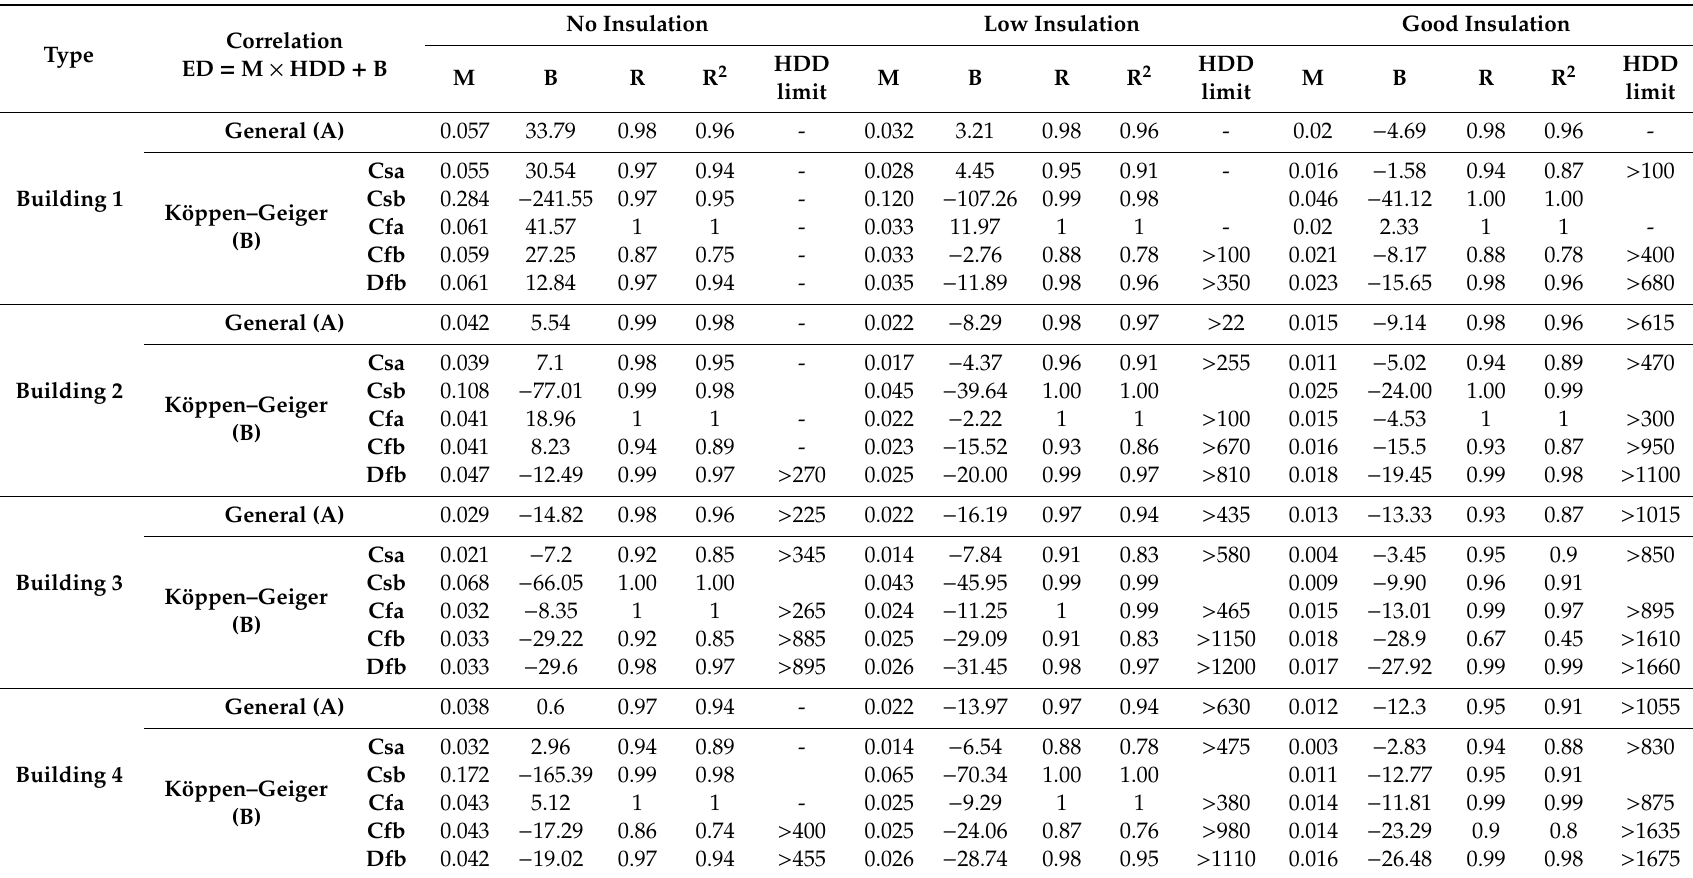
Table 6. Correlations between HDD and heating energy demand for several residential